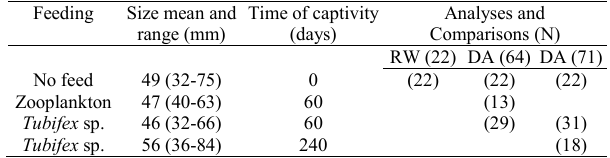
Table 2. Feeding, size, and time of captivity of juvenile Odontesthes hatcheri . Performed analyses (Relative warps, RW), comparisons (Discriminant analysis, DA), and number of individuals (N) are indicated.